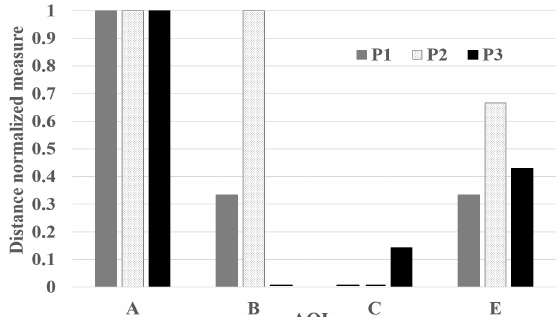
Figure 6. Sample bar plot showing the relative indegree values of various AOIs among multiple observers (i.e. P1, P2, and P3) using the results shown in Figure 4. For this example, the verti- cal axis represents the distance normalized indegree measure value. Only considering the indegree measure (in this example), AOI A is considered as the important AOI by all participants, whereas AOI B is considered important by only